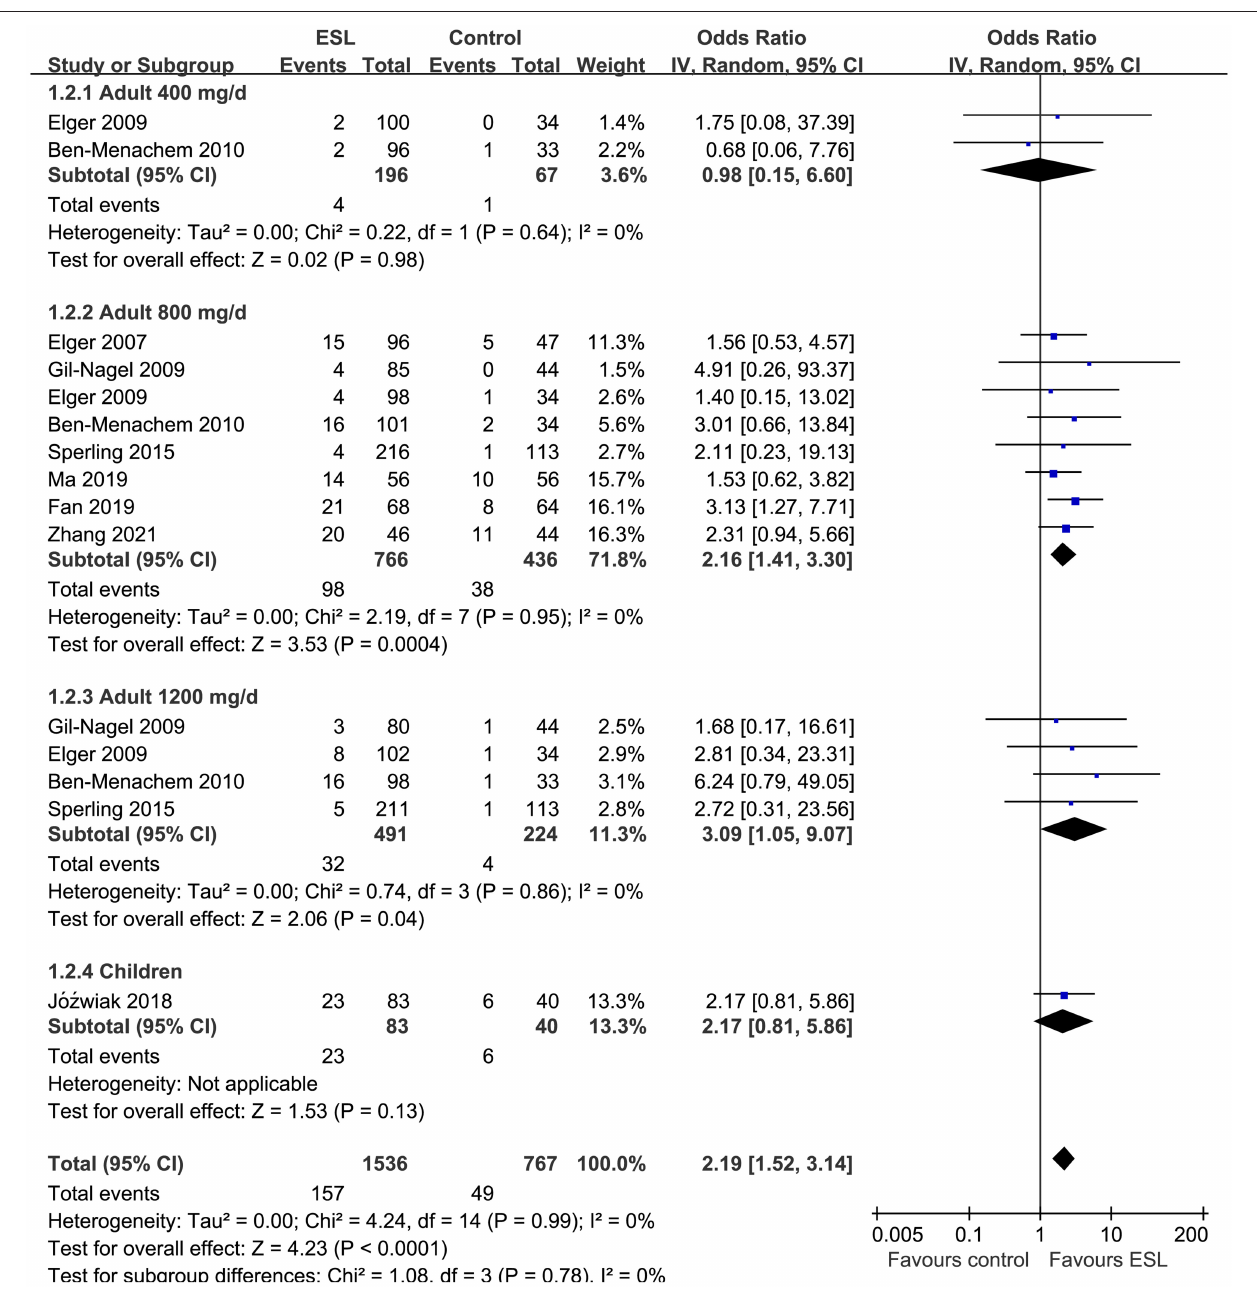
FIGURE 3 | Forest plots for the meta-analysis of the influence of adjunctive ESL on effective rate in adults with FOE according to dose of ESL and in children with all doses.